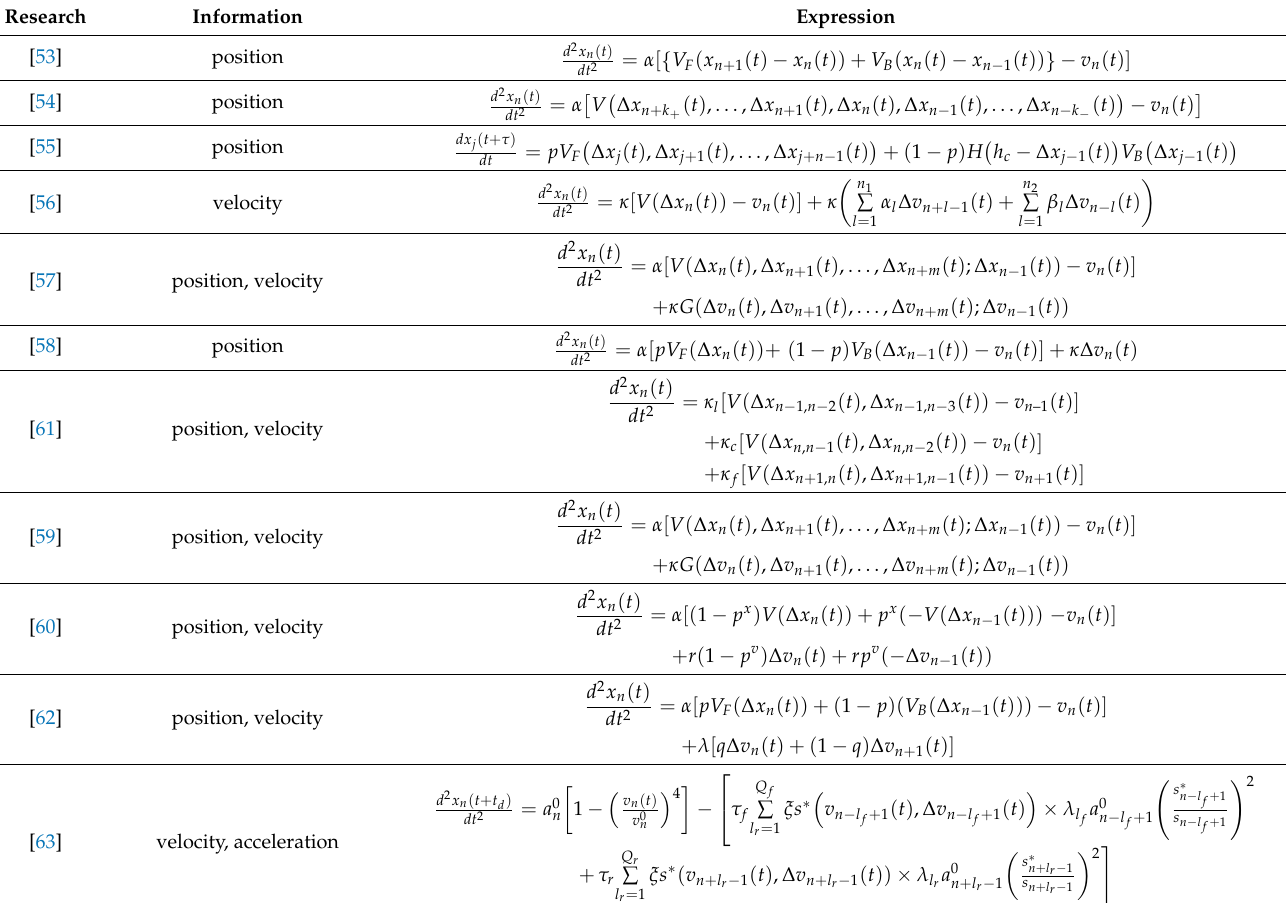
Table 2. Incorporated information in the above models and their